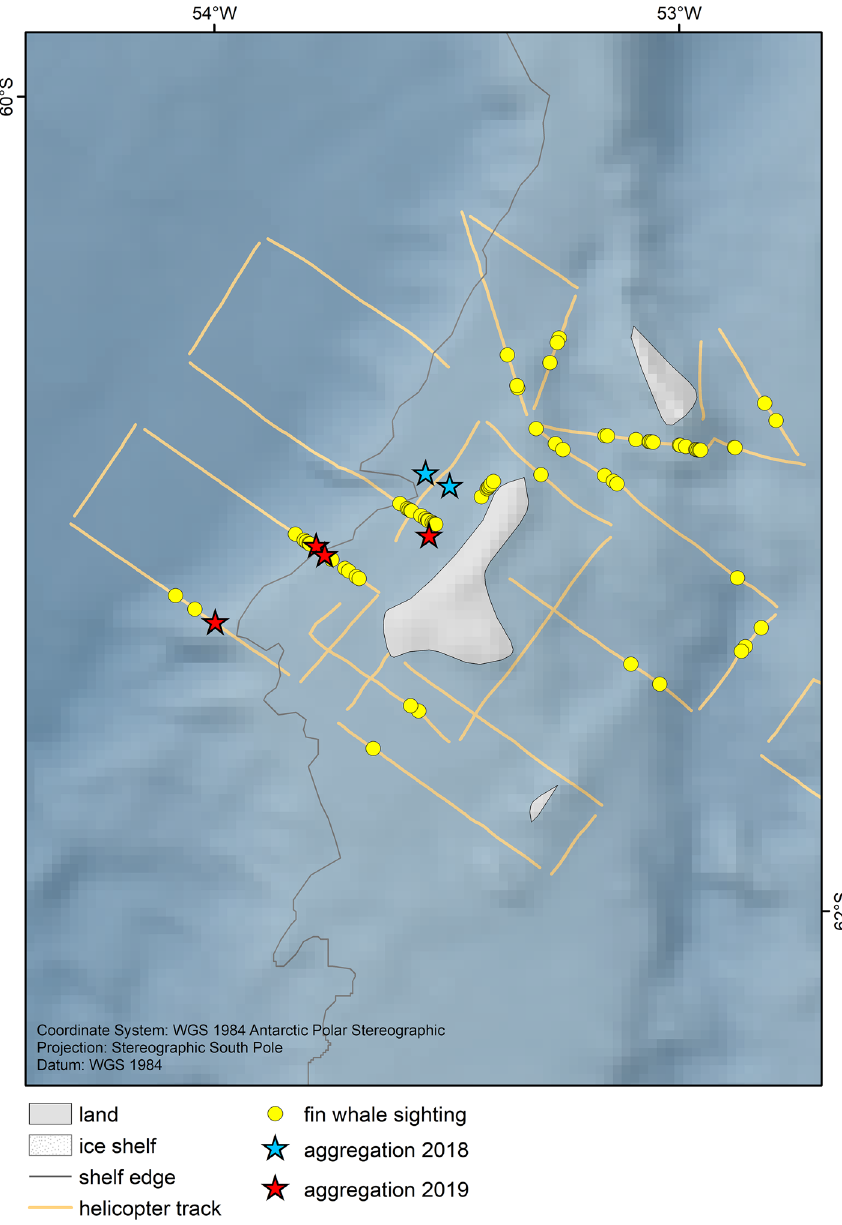
Figure 2. Close up view of survey effort and sightings around Elephant Island. All aggregations during both expeditions were recorded at the northern coast of Elephant Island. The map was composed using ESRI ArcGIS 10.6 (https:// www. esri. com/ en- us/ arcgis/ produ cts/ arcgis- deskt op/ resou